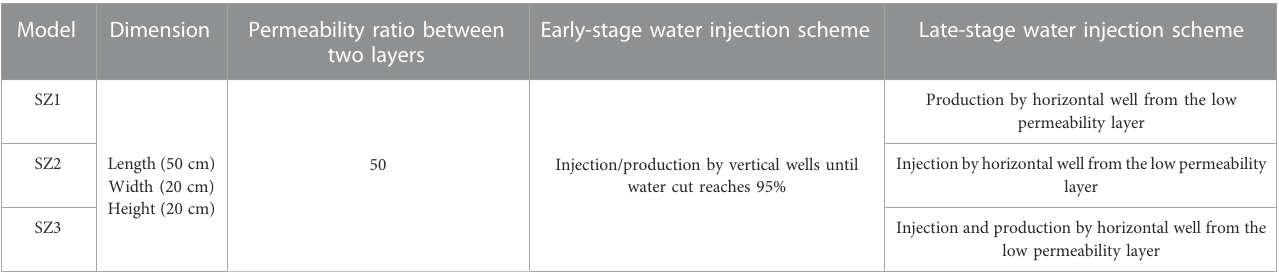
TABLE 1 Basic data of heterogeneity models in positive rhythm